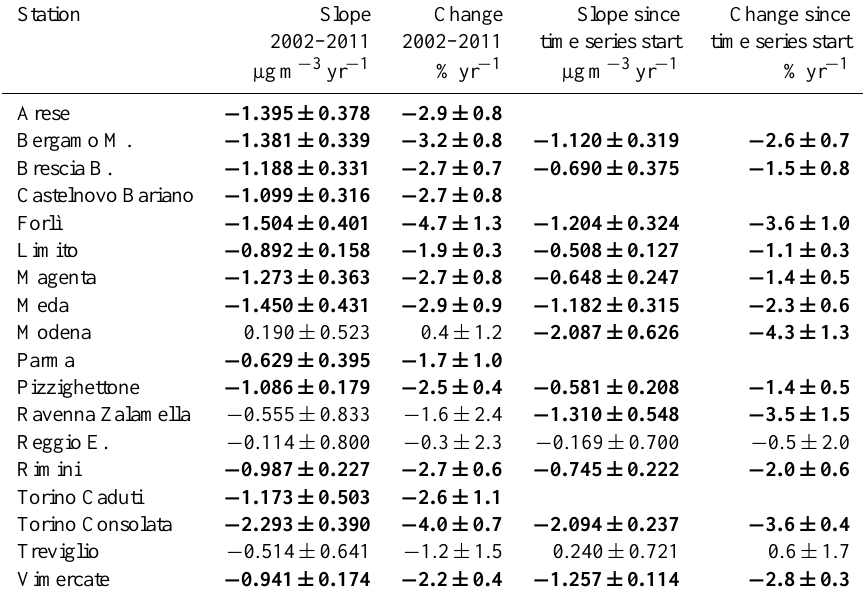
Table 2. GLS trend ( ± standard error) for deseasonalized monthly mean time series of daily PM 10 concentration. Boldfaced values indicate slope significantly different from zero at a 95% confidence level. Station Slope Change Slope since